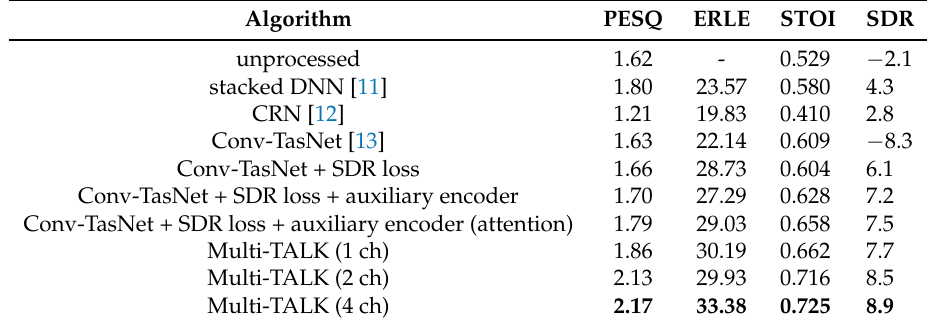
Table 4. Average PESQ, STOI, and SDR under double-talk and the average ERLE under single-talk where the far-end was a speech signal with nonlinearity mismatch.